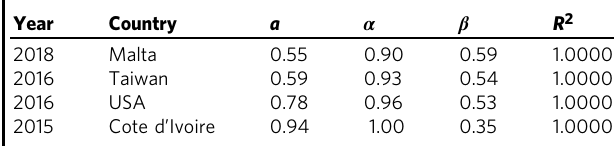
Table 7 The estimated parameters a , α , and β for the Lorenz curves of four countries using Kakwani (1980) ’ s functional form.